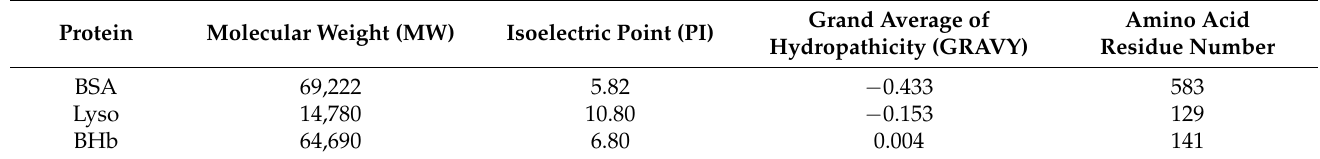
Table 2. The physicochemical properties of